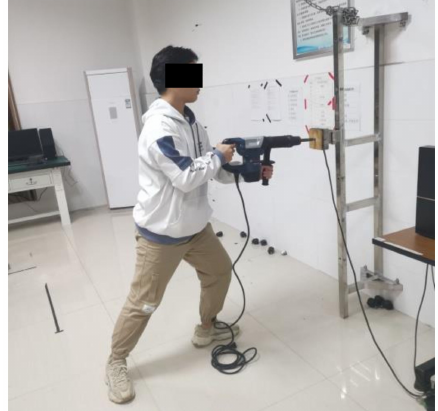
Figure 1. Demolition task in the